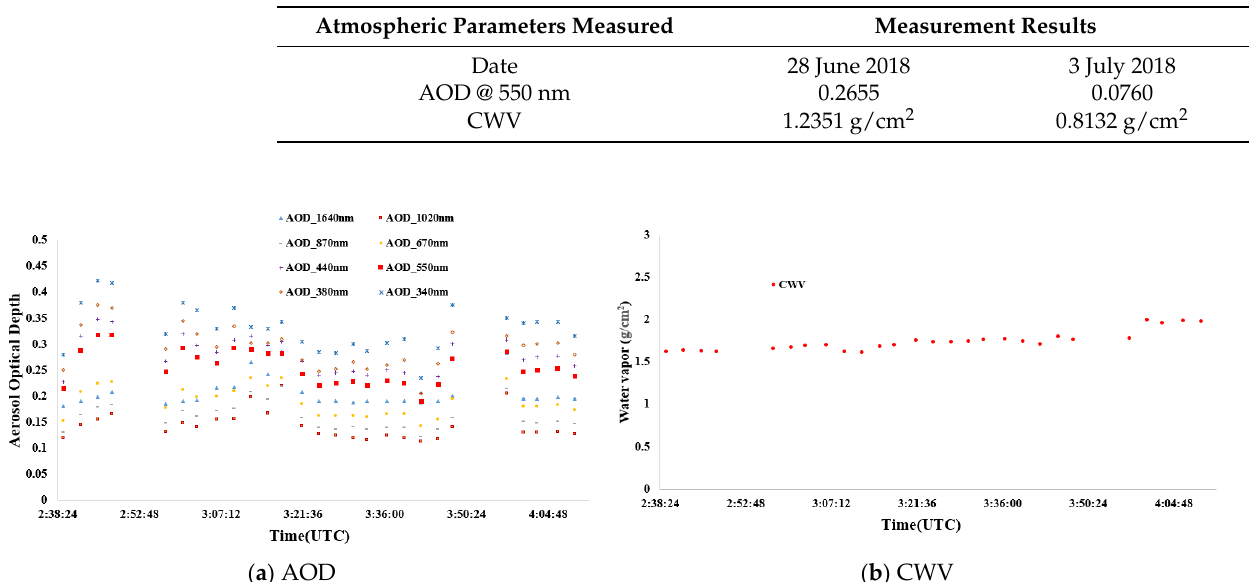
Figure 4. The spatial layout of the radiometric calibration tarps in this study at Baotou site.